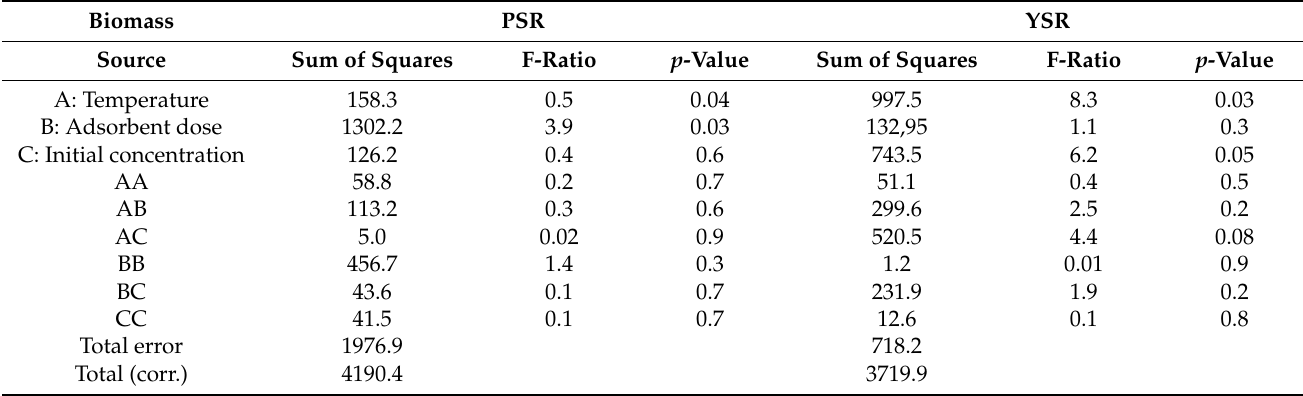
Table 5. Analysis of variance for Cr (VI) adsorption in a batch system.